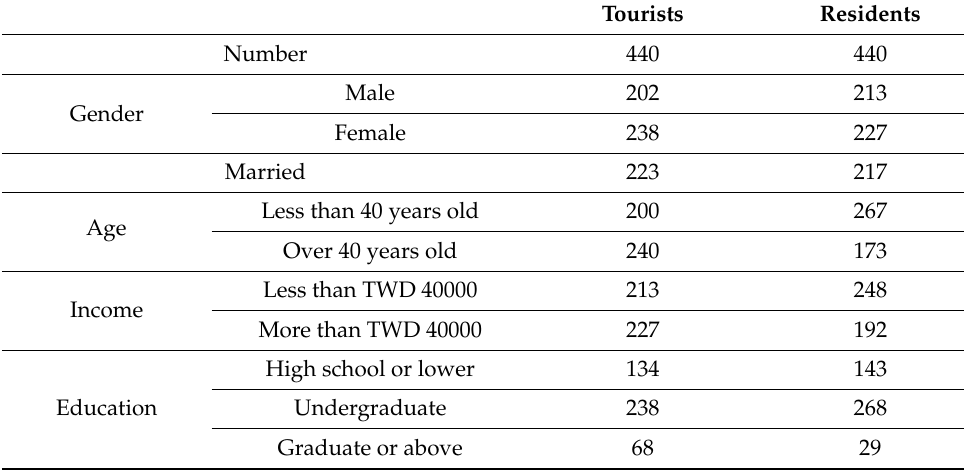
Table 2. Statistical analysis of tourists and